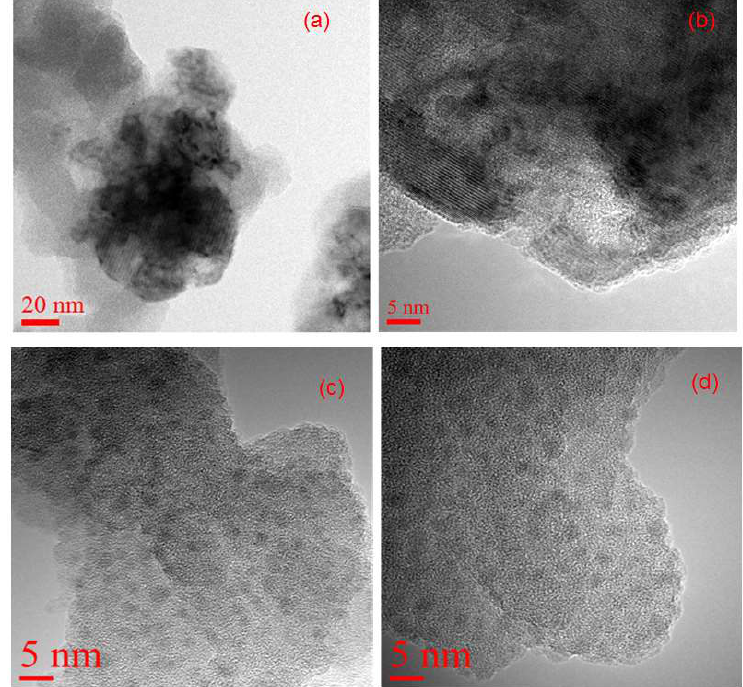
Figure 2. TEM images of as-prepared Co/fumed SiO 2 catalysts using different approaches: ( a ) and ( b ) conventional preparation method; ( c ) and ( d ) improved preparation method.